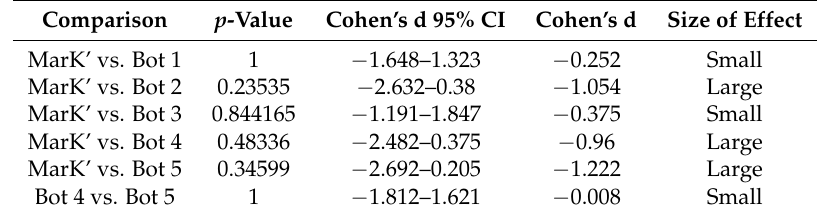
Table 3. Human-likeness Analysis for